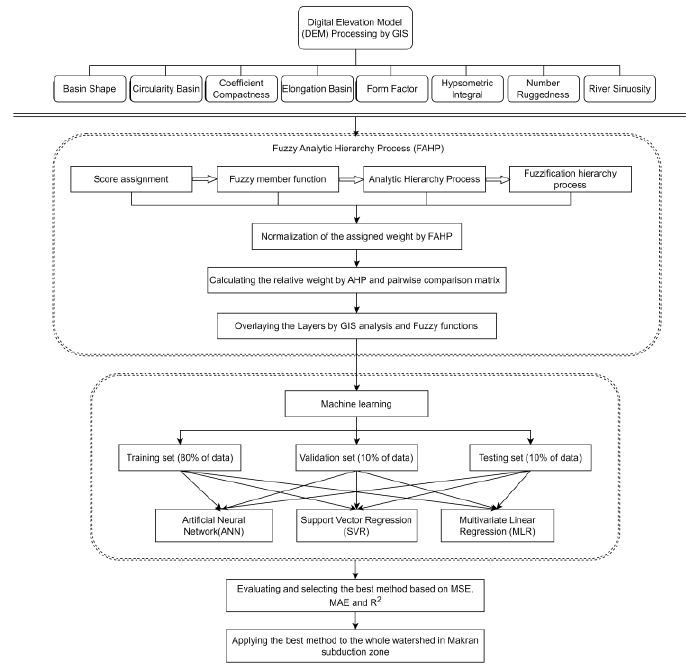
Figure 2. decision tree developed for morphotectonic zoning of Makran region.